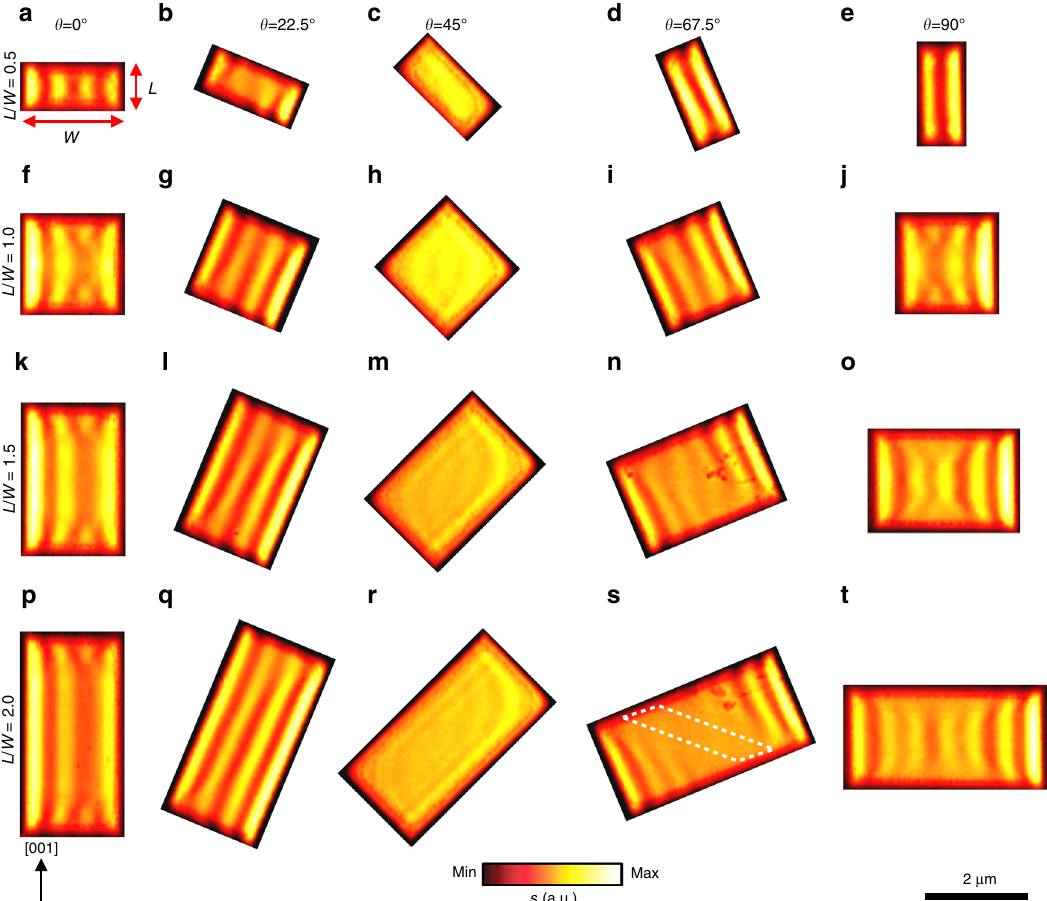
Fig. 3 Edge-tailored PhPs in rectangle α -MoO 3 nanocavities with different aspect ratios and rotation angles. Nano-infrared imaging of near- fi eld amplitude s ( ω ) in rectangle α -MoO 3 nanocavities with different aspect ratios ( L / W , on the left) and angle θ (on the top). The length L and width W are de fi ned in the panel a . The width W of each rectangle is 2 μ m and the thickness is 155 nm. The length L of each rectangle are 1 μ m ( a – e ), 2 μ m ( f – j ), 3 μ m ( k – o ), and 4 μ m ( p – t ), respectively. All the images were measured at frequency ω = 896.9 cm − 1 . The white dotted parallelogram in panel s indicates the forbidden zone of PhPs